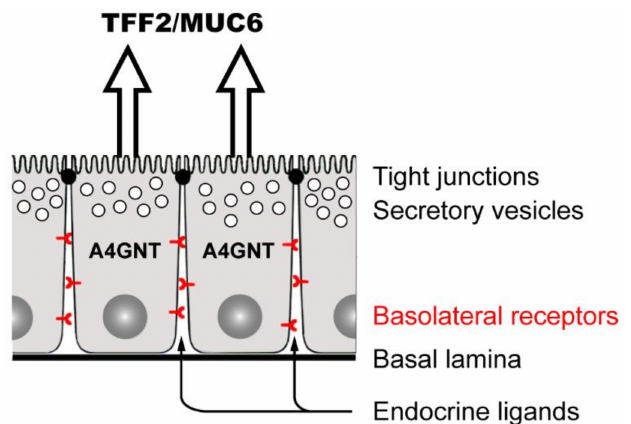
Figure 3. TFF2/MUC6-secreting mucous cells (i.e., mucous neck cells, antral gland cells, and Brunner’s gland cells) and their basolateral receptors. These glandular epithelial cells also specifically synthesize the glycosyltransferase A4GNT [91] responsible for a post-translational modification of certain glycoproteins by a terminal α GlcNAc residue. Targets of A4GNT are MUC6 and likely also various glycosylated basolateral transmembrane proteins (receptors). Generally, these receptors are subject to ligation by numerous endocrine ligands. Furthermore, after a mucosal barrier defect and damage of tight junctionsm exocrine peptides, such TFF2, can also ligate these